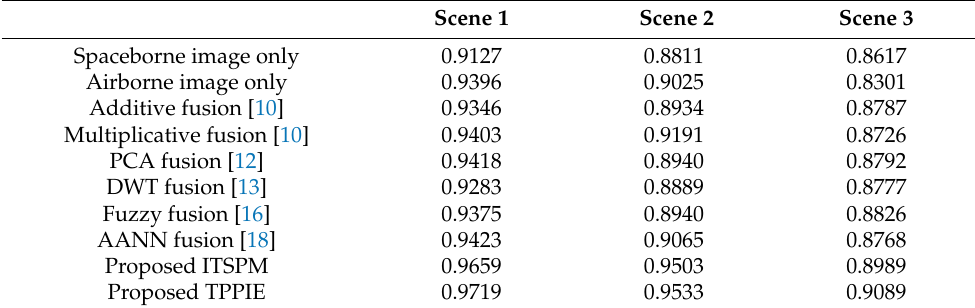
Table 5. Accuracy comparison for three experimental scenes, with respect to the detection results shown in Figures 9–11. The proposed TPPIE method attained the best accuracy